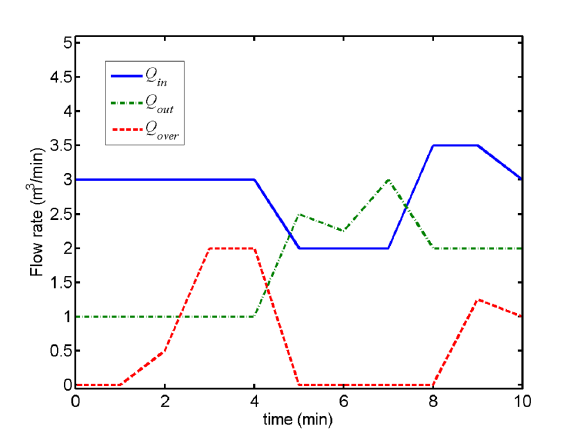
Figure 5. Flow rates in and out of the tank overflow system. Q in and Q out are the model inputs. Q over is a dependent variable, subject to the logical condition of the tank being at the overflow limit.